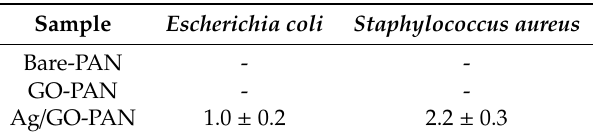
Figure 4. Antimicrobial activity of nanofiber membranes against ( a ) Escherichia coli (gram-negative) and ( b ) Staphylococcus aureus (gram-positive). Table 1. Inhibit zone diameter (mm) of prepared nanofiber membranes for Escherichia coli and Staphylococcus aureus.